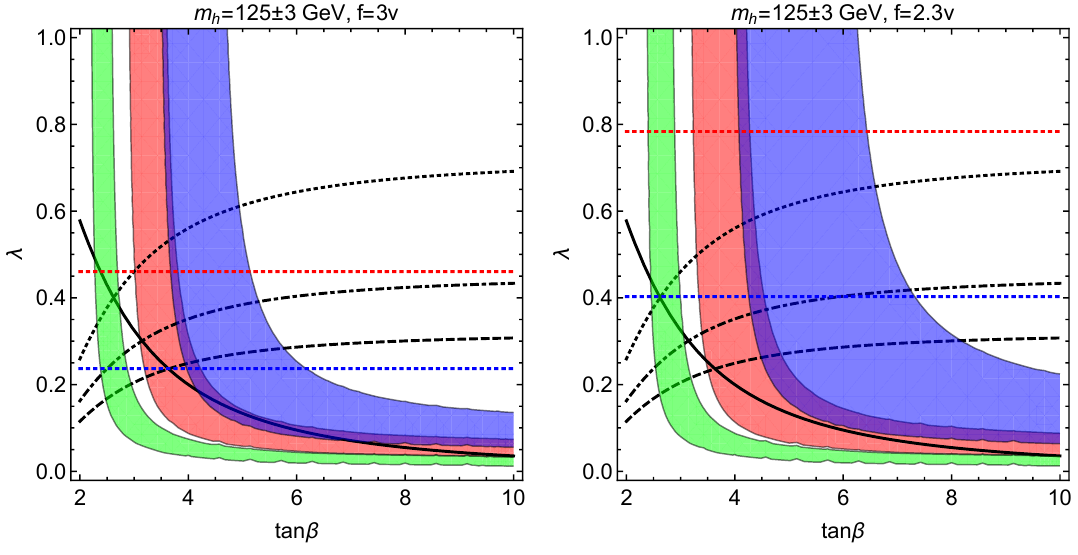
Figure 2 . The SM-like Higgs mass of m h = 125 (cid:6) 3 GeV in the plane tan (cid:12) - (cid:21) for several values of the stop masses: 700 GeV (blue), 1 TeV (red) and 2 TeV (green) in the decoupling limit of SUSY Twin Higgs models. Horizontal dotted lines correspond to minimal value of (cid:21) for which there is no tuning from the stop sector assuming the cut-o(cid:11) scale (cid:3) = 100 m stop . The black solid lines show (cid:21) F with (cid:21) S = 1 : 9 i.e. the value for which the Landau pole is ten times above the singlet mass scale in the F -term model. The dashed, dash-dotted, dotted lines show (cid:21) D with (cid:15) = 0 and g X = 1 : 6 ; 1 : 9 ; 2 : 4 i.e. the value for which the Landau pole is ten times above the X gauge boson mass scale for the mirror, fraternal and (cid:13)avor non-universal D -term Twin Higgs model, respectively. In the left (right) panel f=v = 3 (2 :